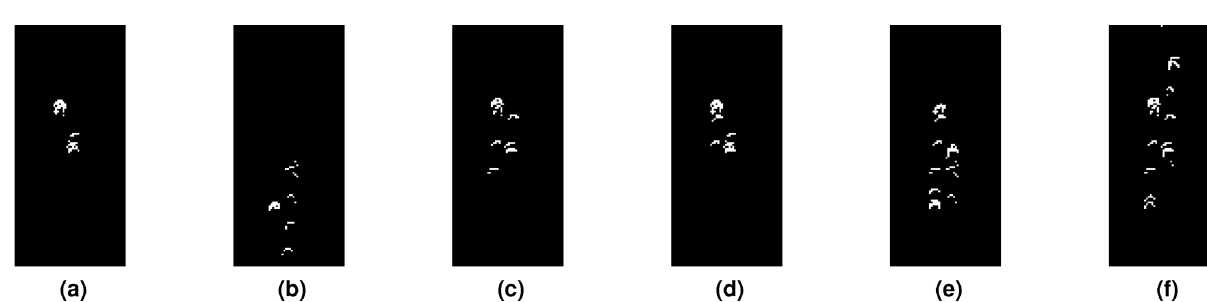
Figure 3. Aggregated occupancy maps for ( a ) C 5 × 0 , ( b ) C 5 × 1 , ( c ) C 5 × 2 , ( d ) C 10 × 0 , ( e ) C 10 × 1 , and ( f ) C 10 × 2